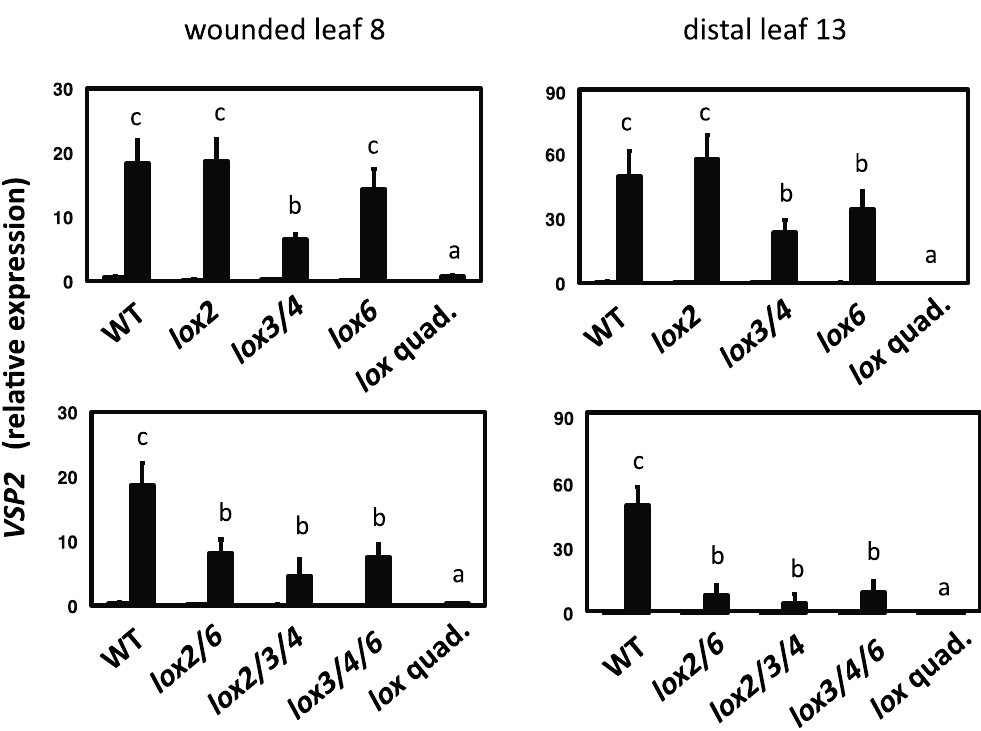
Figure 3. Wound-induced VSP2 expression in 13-lox mutants. Leaves 8 (wounded) and 13 (distal) were snap-frozen at 4 h after wounding (filled bars) or harvested at the same timepoint from unwounded plants (unfilled bars). Data from three (unwounded controls) to four (wounded samples) biological replicates ( ˘ SD). Letters (a, b, and c) refer to significant differences (ANOVA and t-test; p < 0.05). VSP2 transcript levels in unwounded plants is low and statistics are shown for wounded treatments only. WT = wild type; lox2 = lox2-1 ; lox3/4 = the lox3B lox4A double mutant; lox6 = lox6A ; lox2/6 = the lox2-1 lox6A double mutant; lox2/3/4 = lox2-1 lox3B lox4A triple mutant; lox3/4/6 = lox3B lox4A lox6A